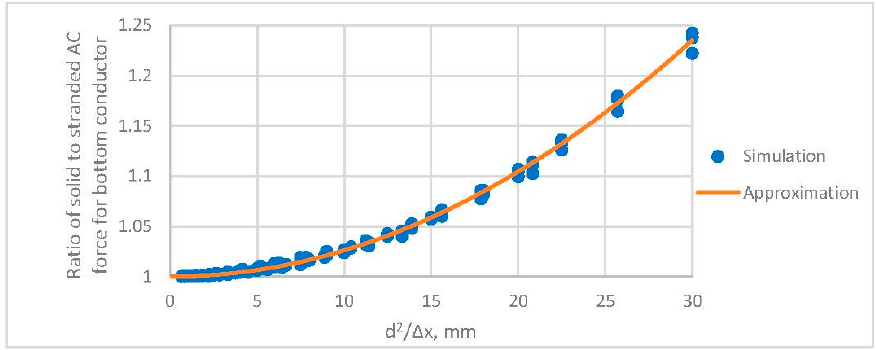
Figure 9. Simulation results and approximation function for solid conductor.